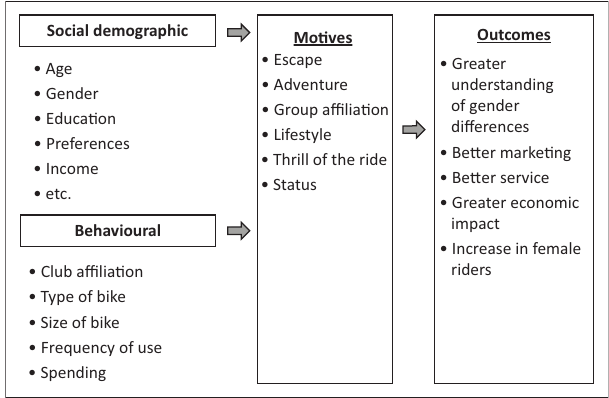
FIGURE 1: Outcome-based analysis of